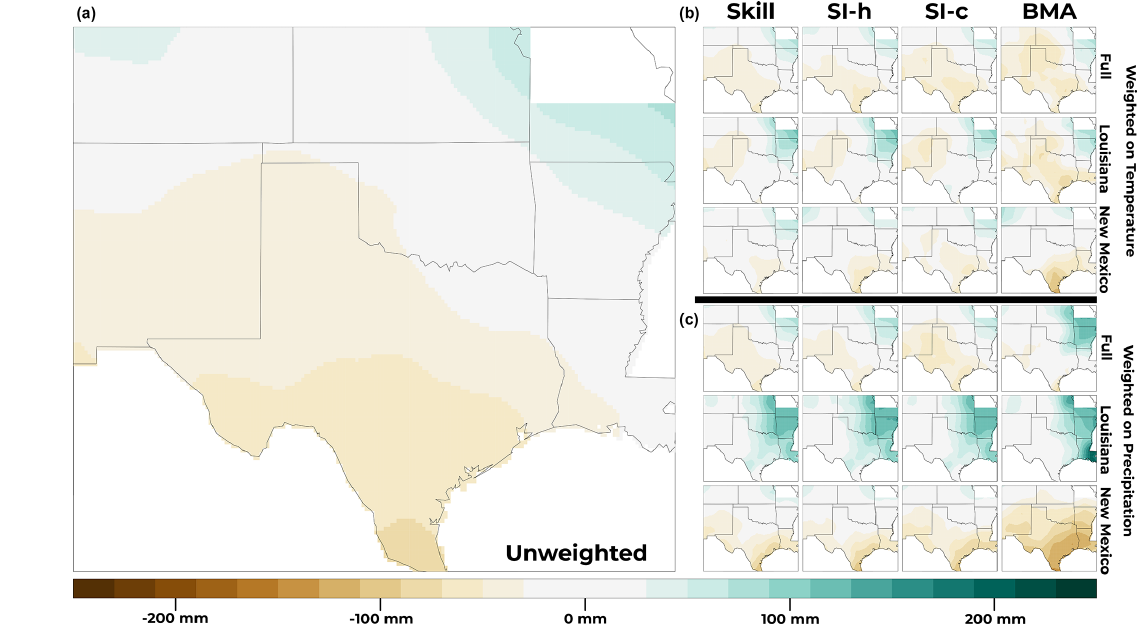
Figure 9. CMIP5 ensemble mean projected precipitation change (2070–2099, RCP8.5) from the unweighted ensemble (a) and each weighted ensemble mean (b, c) . On the right side, the columns from left to right are for the Skill, SI-h, SI-c, and BMA weighting schemes, respectively. The plots in panel (b) show the results for weights derived using temperature (tmax), and the plots in panel (c) show the results for weights derived using precipitation (pr). Within a group of 12 on the right-hand side, the top row is for weights derived using the full domain, the middle row is for weights derived using the Louisiana domain, and the bottom row is for weights derived using the New Mexico